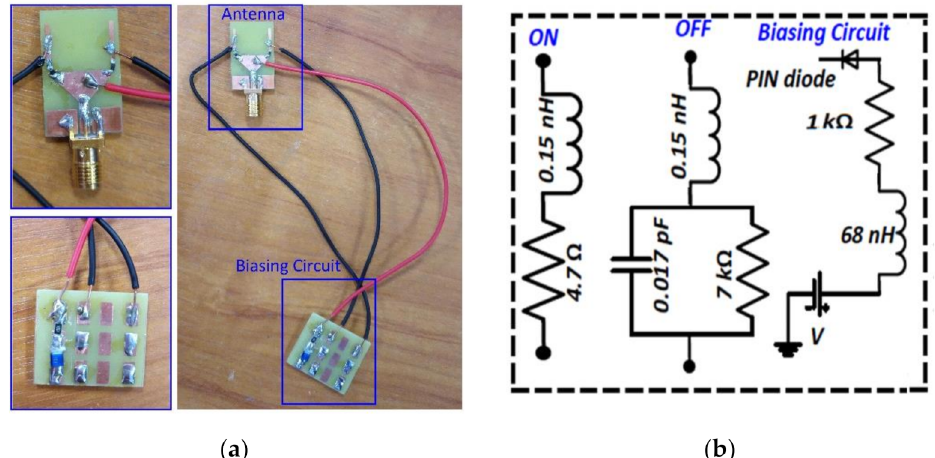
Figure 6. ( a ) Fabricated antenna with biasing circuit and ( b ) equivalent circuit model for the PIN diode (ON and OFF state) and biasing